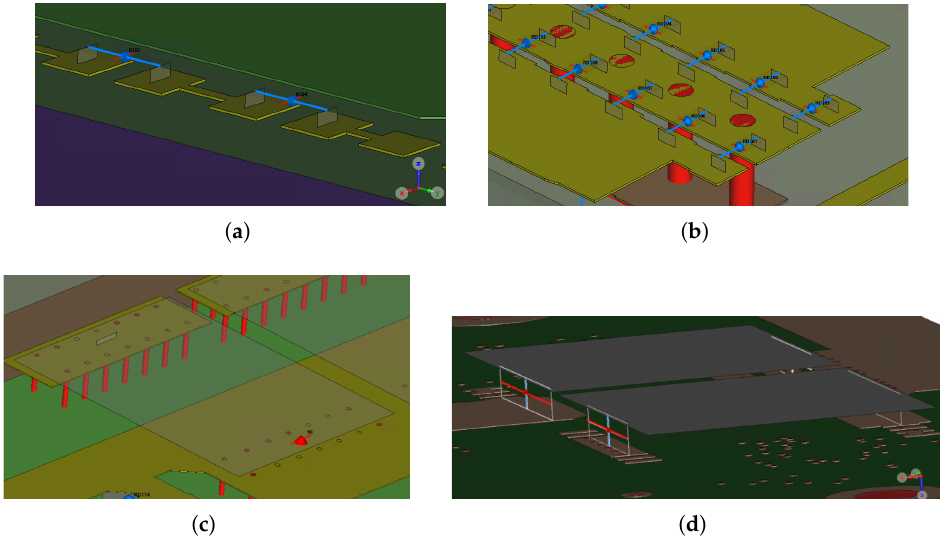
Figure 9. ( a , b ) Face lumped elements to model the ideal electrical behavior of resistors, inductors, and capacitors which are not part of the halfbridge circuit. ( c ) Face lumped ports to investigate the impact of the capacitors between DC+ and DC − on the EMC’s behavior. ( d ) Face lumped ports to investigate the impact of the transistors on the EMC